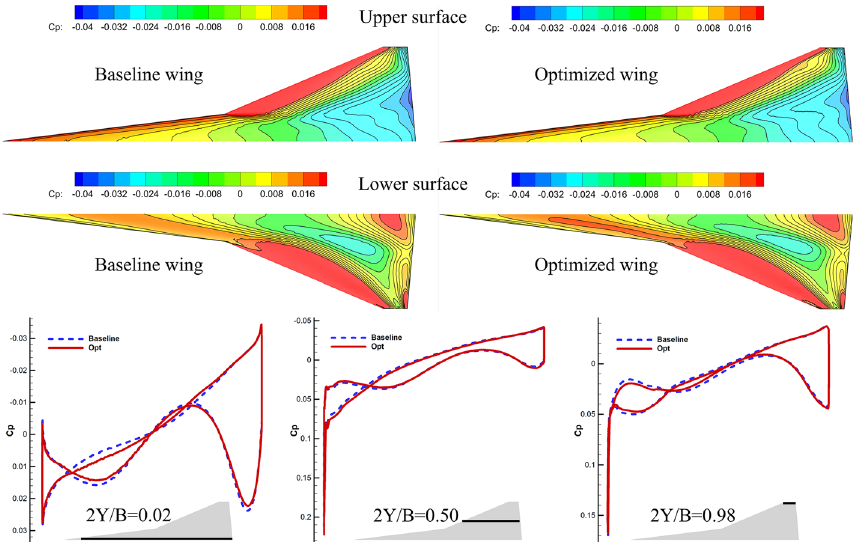
Fig. 27 Comparison of pressure coefficient contours and sectional pressure coefficient distributions at three wing spanwise locations for the baseline and optimized profiles (optimization case